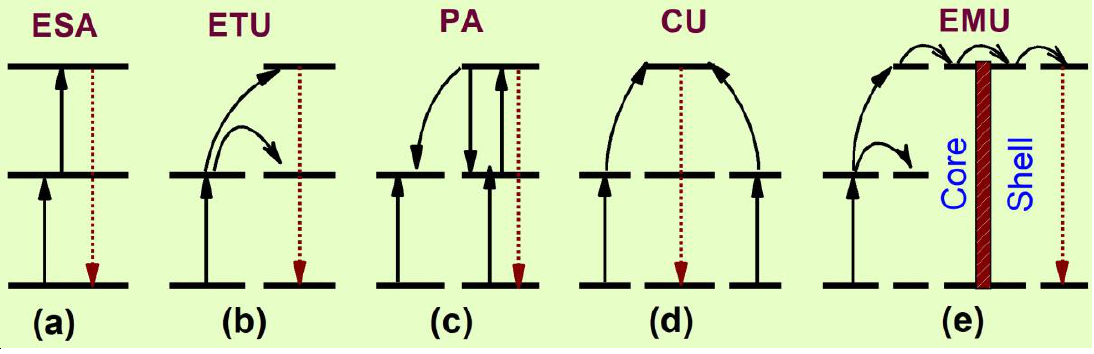
Figure 2. Schematic representation of different upconversion processes [47].